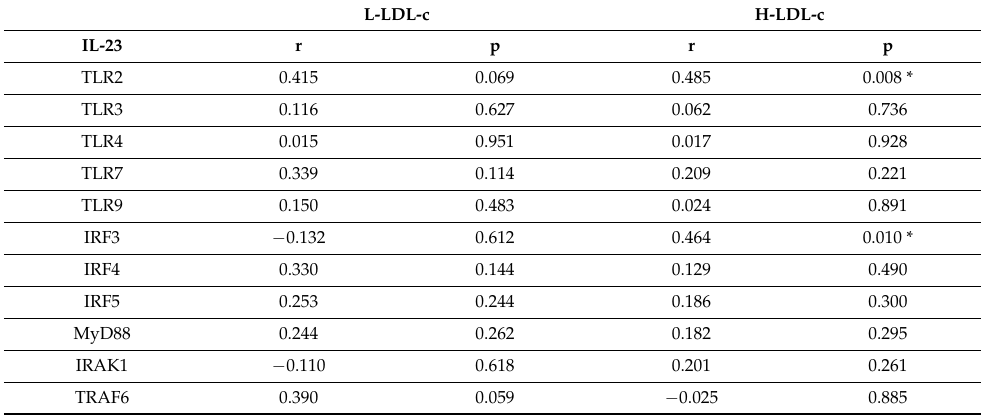
Table 4. Adipose tissue gene expression of IL-23 associates with TLR2 and IRF3 in people with